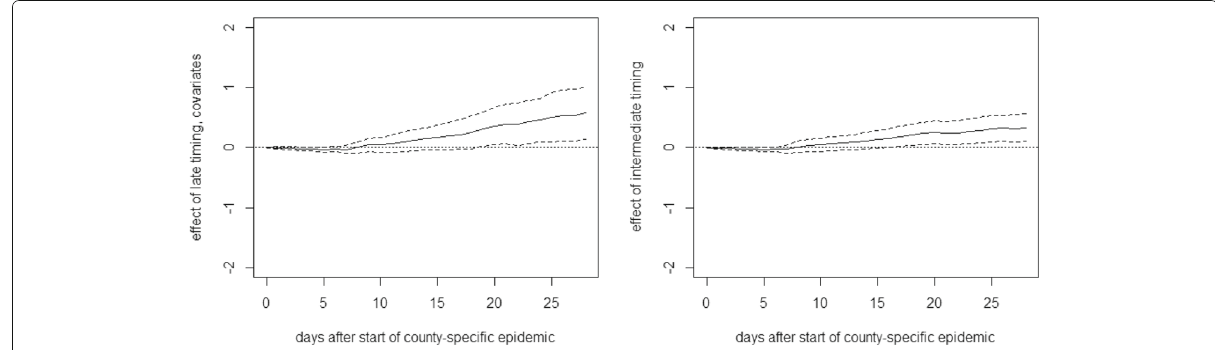
Fig. 3 OLS effects of late (left) and intermediate (right) timing of measures on cumulative deaths per 10,000 inhabitants in